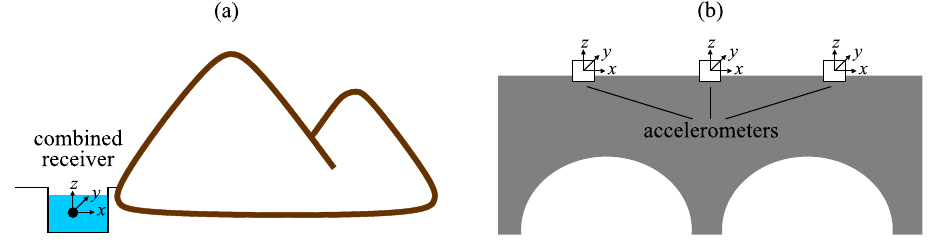
Figure 1. Installation schemes of ( a ) combined receiver and ( b )